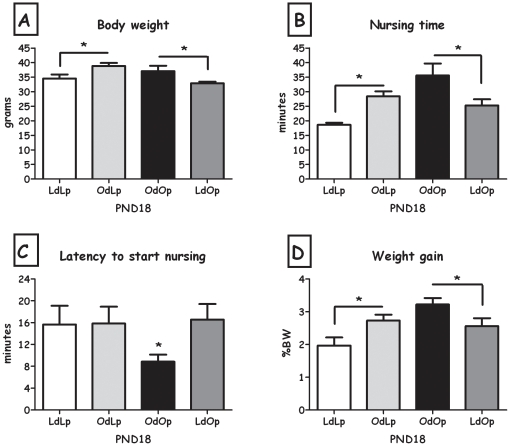
Nursing test.
A: Pups' body weight in grams at the time of the test (PND18); B: Nursing episode duration in minutes; C: Latency to start nursing in minutes; D: Pups' body weight gain (percentage of body weight) after nursing test (D). Data are presented in means and SEM. *p<0.05 for pup-strain comparison between cross and in-fostering groups. N = 6–7 per group.